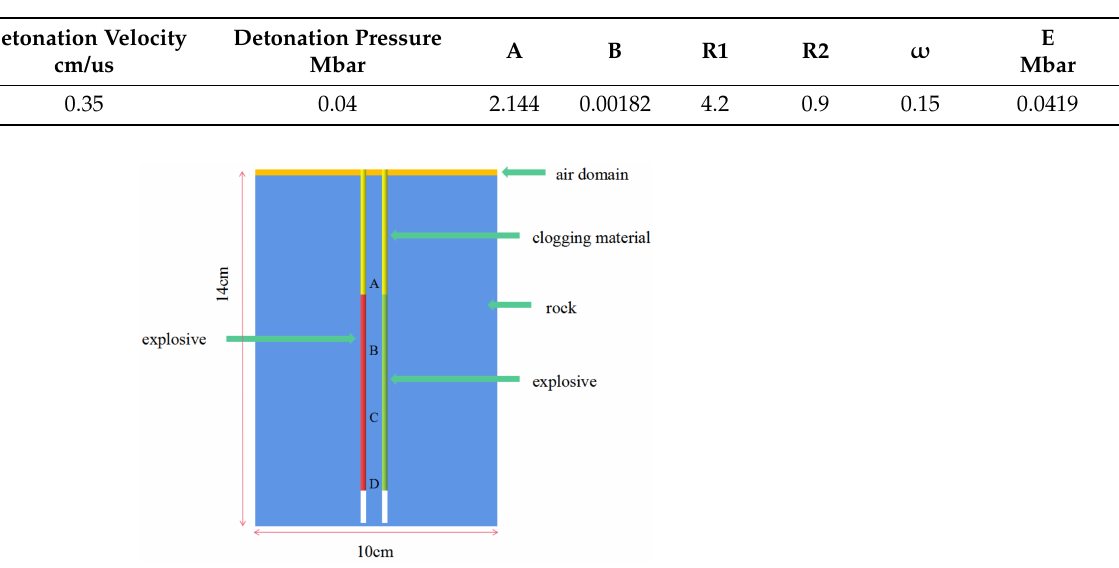
Table 4. Material coefficients of emulsion explosive.